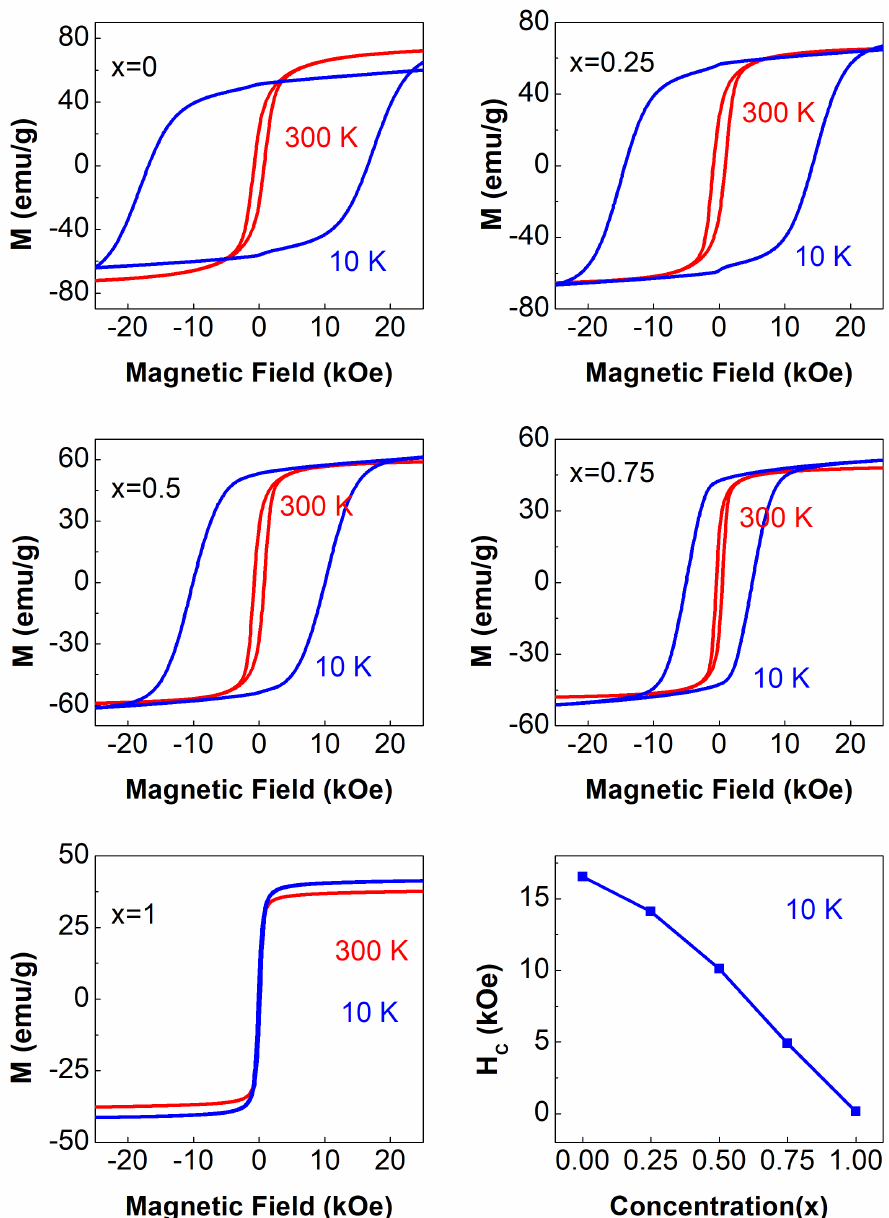
Figure 6. Magnetic hysteresis loops for the Ni x Co 1 − x Fe 2 O 4 ferrites with 0 ≤ x ≤ 1. The figure in the lower right corner shows the variation of H c (at 10 K) with Ni